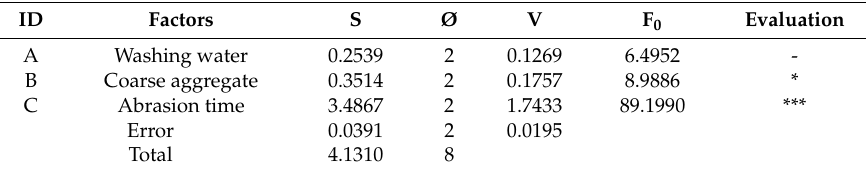
Table 7. Variance analysis for absorption ratio of recycled fine